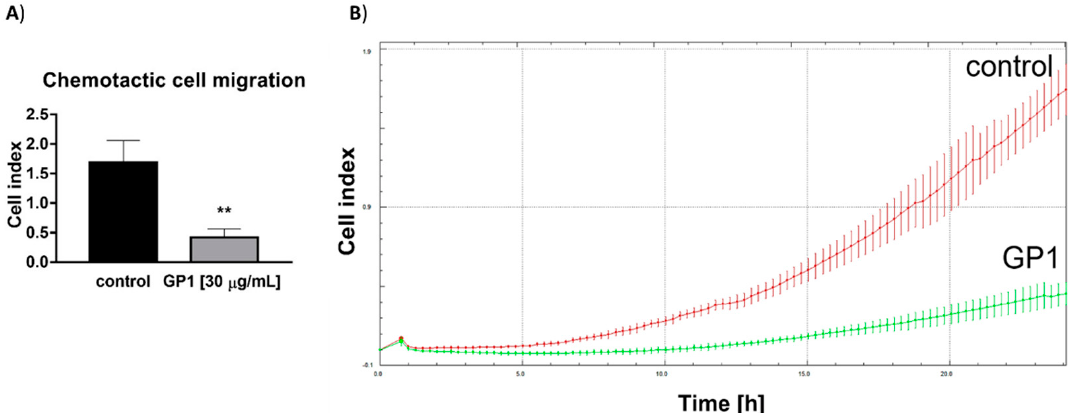
Figure 7. ( A ) Cell index of control and graphene-treated cells after 24 h migration ( A ). Statistical significance was evaluated with an Unpaired t -test. ** significant difference from control cells, p < 0.05. ( B ) Representative migration curves of control and GP1-treated cells from three independent